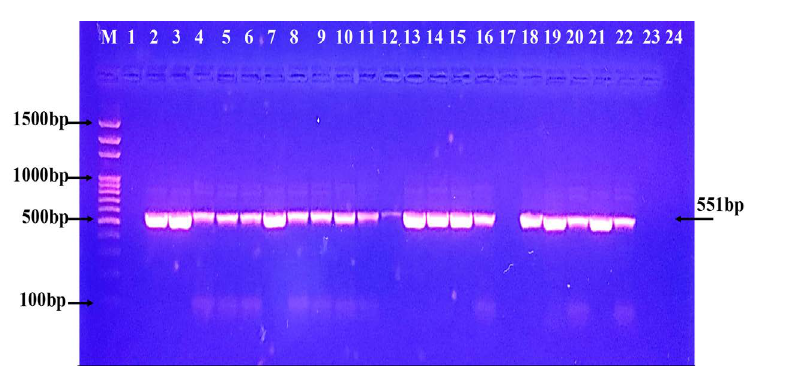
gene the resistant P. aeruginosa isolates to carbapenem. M: ladder, SME